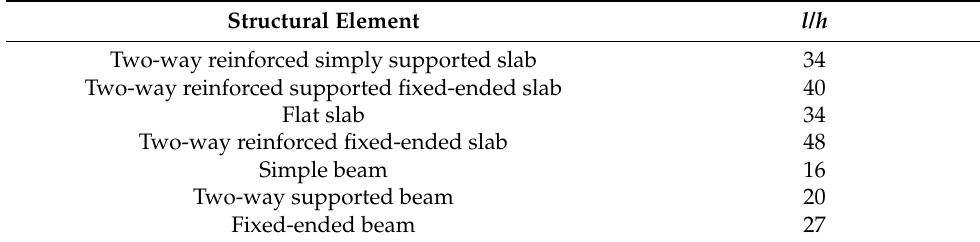
Table 1. Ratio values (span/height) for indirect deformation control in REBAP. Structural